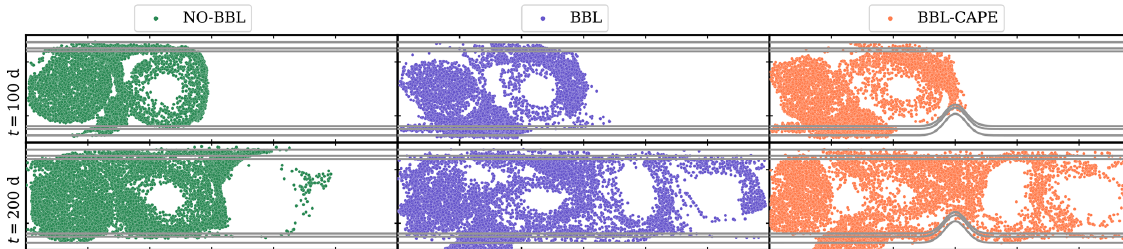
Figure 12. Positions of particles for the three experiments at days 100 and 200.